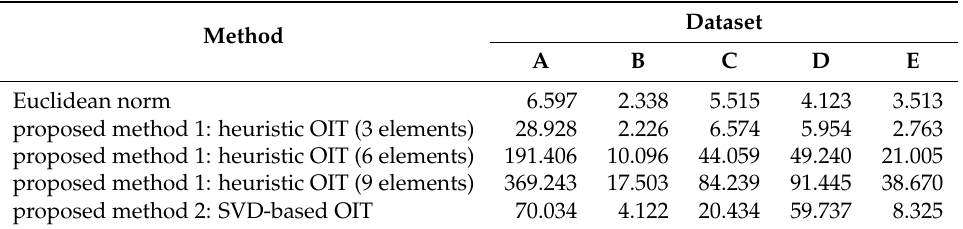
Table 2. Runtimes of the three OIT techniques (in sec) for datasets